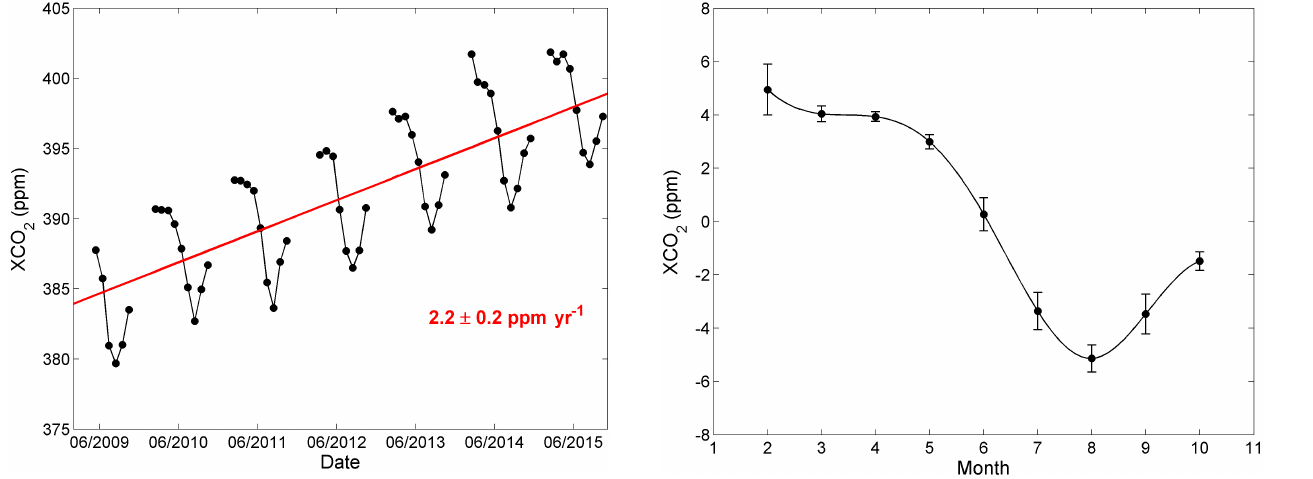
Figure 7. Average seasonal cycle of XCO 2 over Sodankylä, monthly averages (black dots) and standard deviations (vertical lines). The average seasonal cycle was calculated after the trend